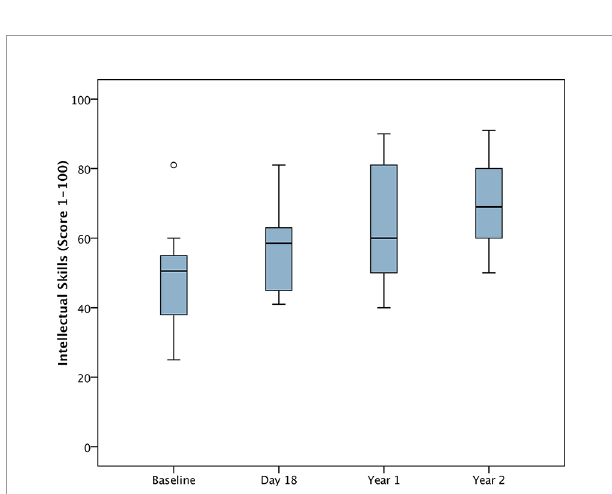
FIGURE 6 | Scatterplot ADOS Total score change versus DD-C-GAS Social behavior change (N = 26). Changes for ADOS scores were calculated as differences baseline – Year 2 to present improvements as positive values.